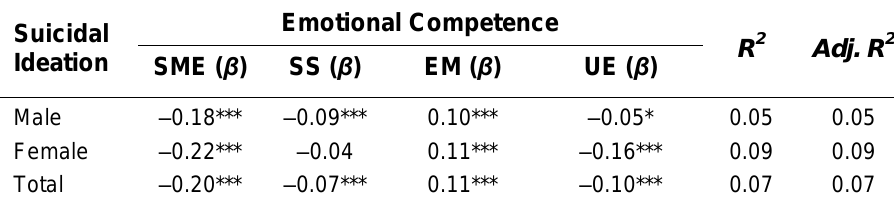
Prediction of Adolescent Suicidal Ideation from Emotional Competence